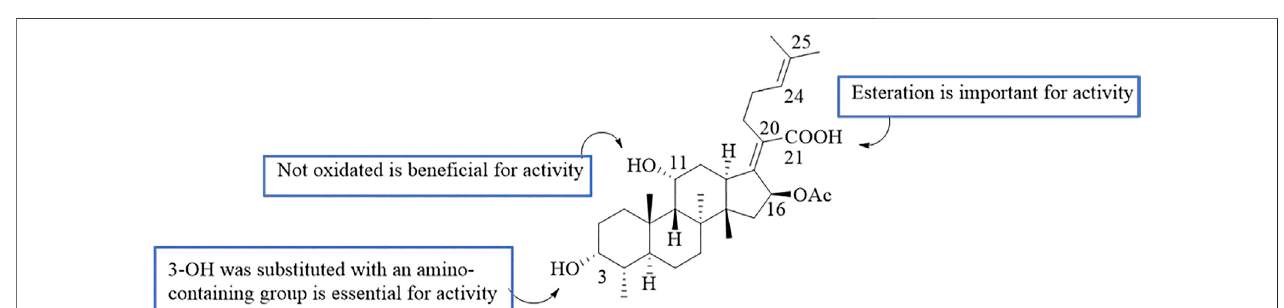
FIGURE 7 | Structural formulae of compounds 26 – 29 .